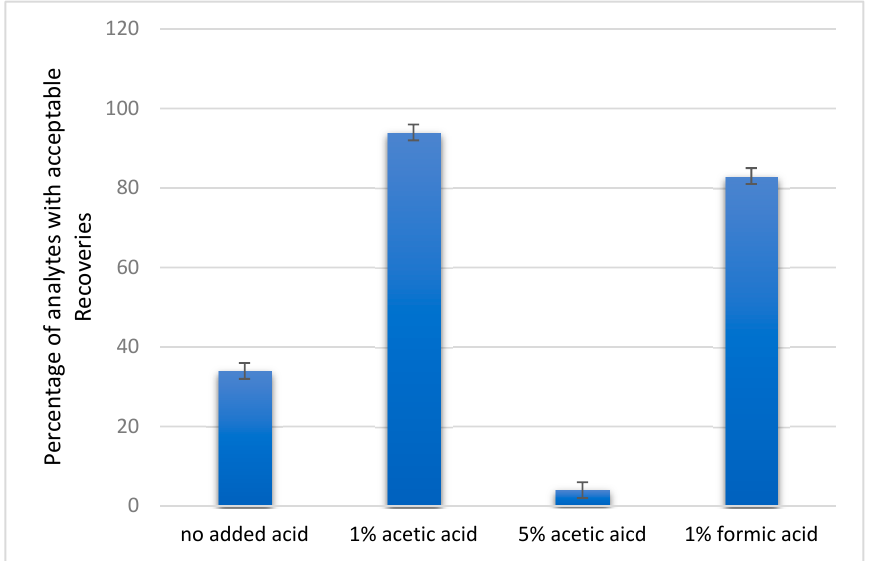
Figure 5. Percentage of pesticides and mycotoxins with acceptable recoveries in the range 70–120% in the absence of acids and the presence of 1% acetic acid, 5% acetic acid, and 1% formic acid.